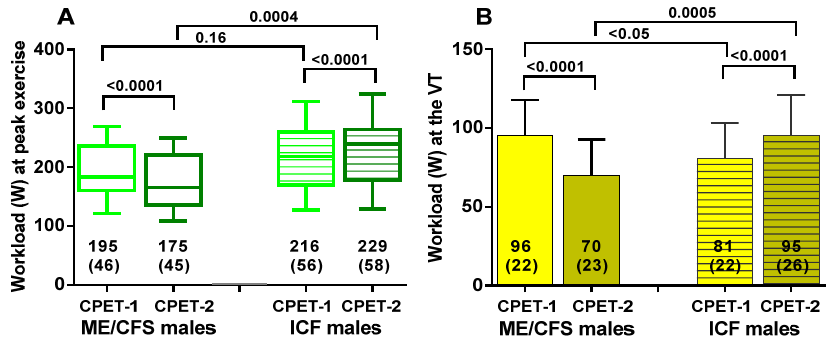
Figure 3. The workload at peak exercise for CPET-1 and CPET-2 panel ( A ) and at the ventilatory threshold for CPET-1 and CPET-2 panel ( B ). On the left side, the values of day 1 and day 2 are shown for male ME/CFS patients (clear boxes/columns); on the right side, the values of day 1 and day 2 for male ICF patients (striped boxes/columns). Workload at peak exercise for CPET-1 and CPET-2 panel ( A ) and at the ventilatory threshold for CPET-1 and CPET-2 panel ( B ). Legend Figure 3: CPET: cardiopulmonary exercise test; ME/CFS: myalgic encephalomyelitis/chronic fatigue syndrome; ICF: idiopathic chronic fatigue; VT: ventilatory threshold.